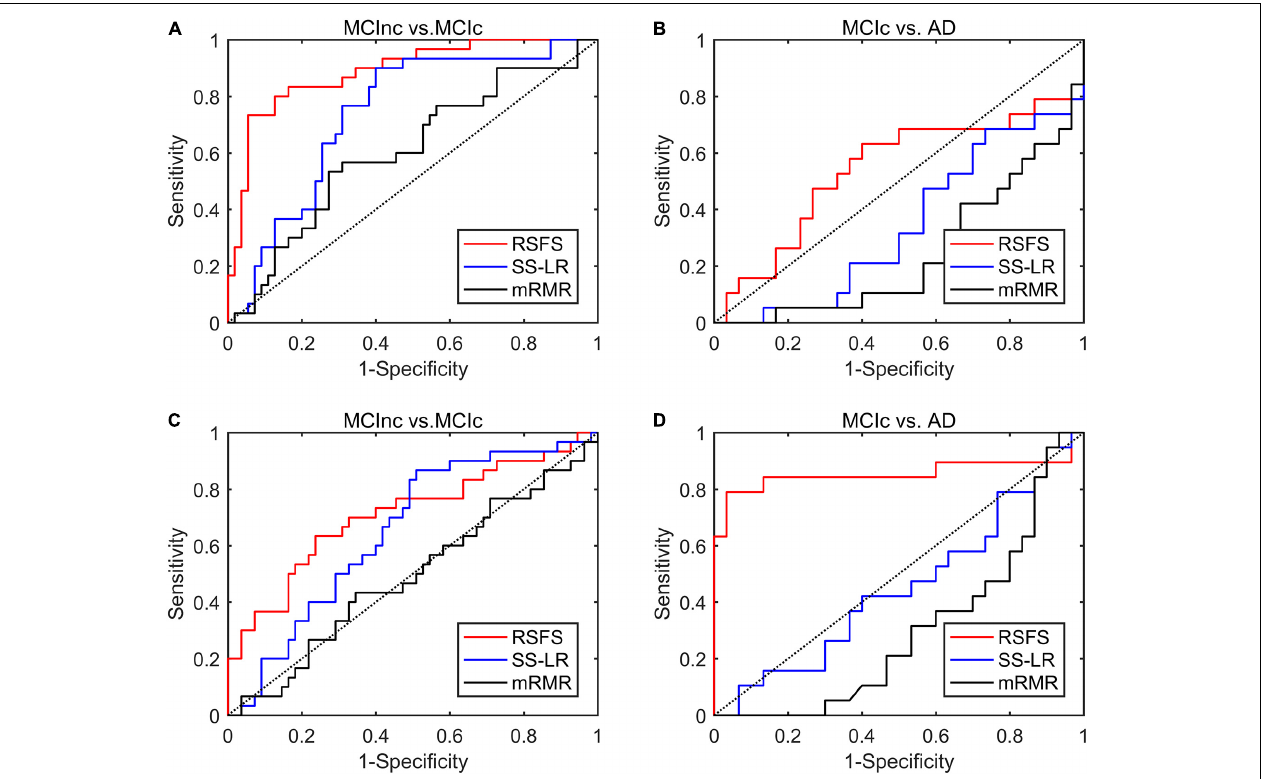
FIGURE 2 | ROC curves of the three algorithms performed SVM classifier using the top 10 features. (A) MCInc vs. MCIc group at cost = 39%, (B) MCIc vs. AD group at cost = 39%. (C) MCInc vs. MCIc group at cost = 19%, (D) MCIc vs. AD group at cost = 19%. TABLE 2 | Classification results performance of different methods using the top 10 features. GROUP